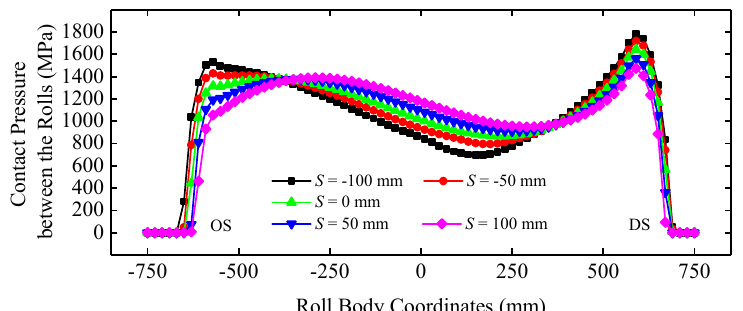
Table 3. The coefficient K at different rolling forces q .